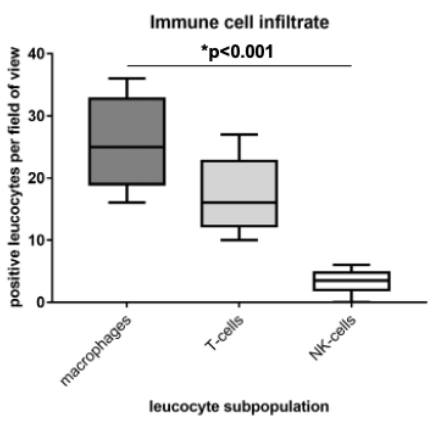
Figure 4. Macrophages were identified as main part of the immune cell infiltrate. The immune cell infiltrate was quantified by counting positive cells per field of view (20 × lens; n = 12) in immunofluorescence double staining. Most infiltrating cells were CD68 positive macrophages, followed by CD3 positive T-cells. Just a few CD56 positive NK-cells were